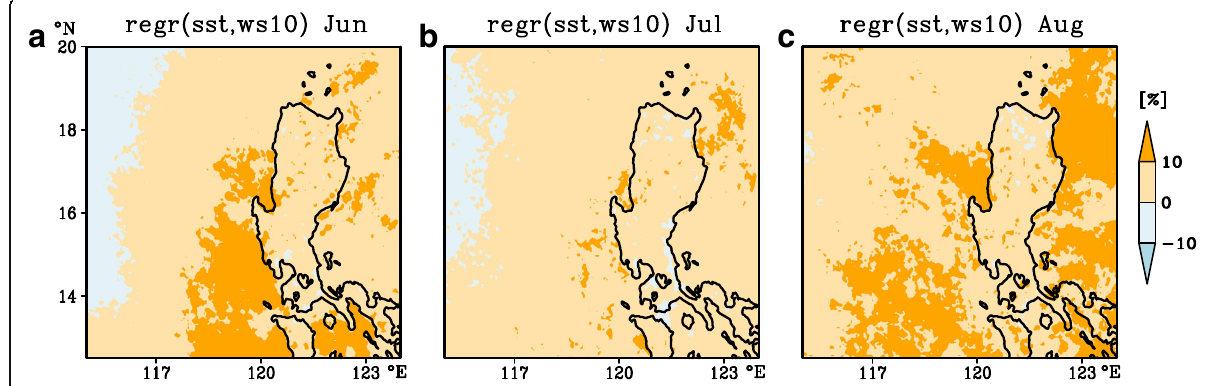
Fig. 9 Spatial map of the regression coefficients of the sensitivity of 10 m winds (ws10) to the monthly SST anomaly of the WSST reference region for 1982 – 2012 for the months of a June, b July, and c August. The values are shown in percentage relative to the 31 yr.-mean ws10 from